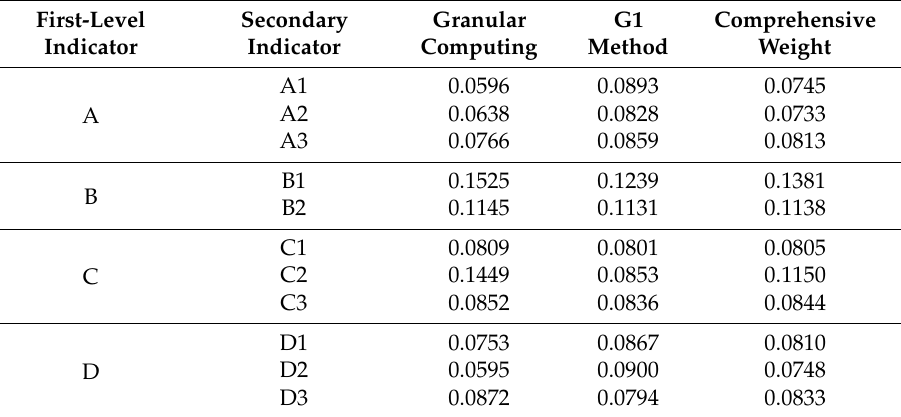
Table 14. The weight of each index obtained by different